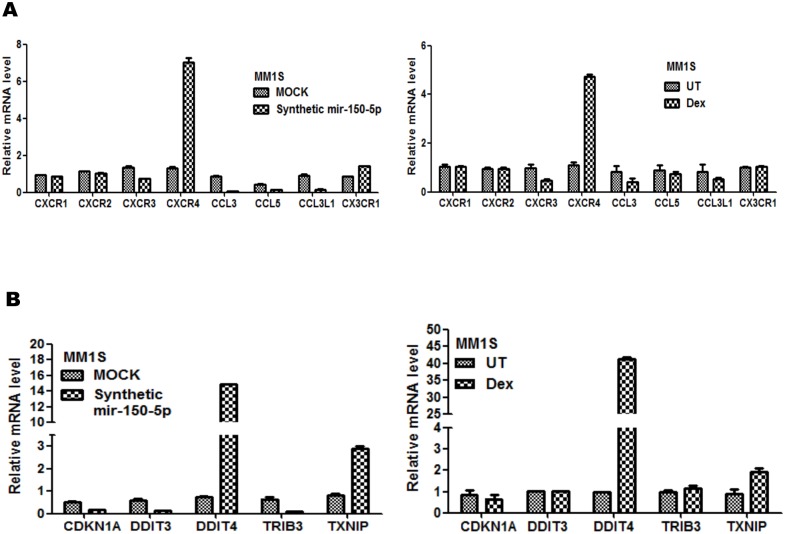
Mir-150-5p transfection is associated with complex regulation of chemokine, cell cycle, UPR/mTOR signaling.Illumina BeadChip Gene Expression results of chemokine receptors or ligands (A), or regulators of cell cycle, unfolded protein stress (UPR/mTOR signaling) (B), are presented as bargraphs, reflecting mean of gene expression fold change from three independent experiments of MM1S, treated for 72 h with 1 µM Dex versus control setup (UT), or else of MM1S cells transfected for 72 h with synthetic mir-150-5p versus mock transfection.